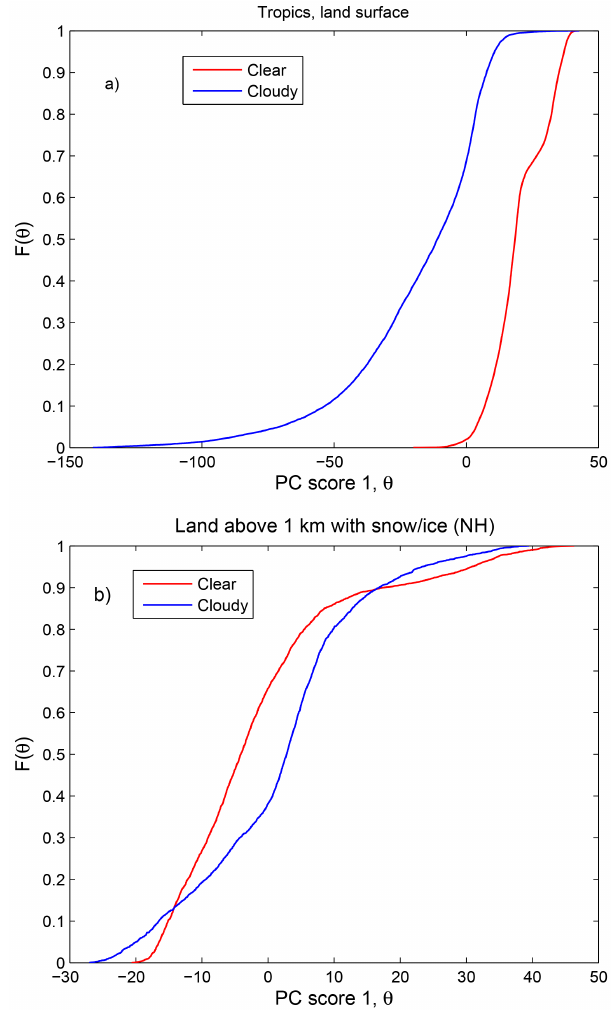
Figure 6. Example of cumulative distribution function, F , of the first PC score of the statistic vector x (Eq. 10) over land surface. (a) Tropical climatic zone (daytime); (b) land above 1km with snow/ice (NH,